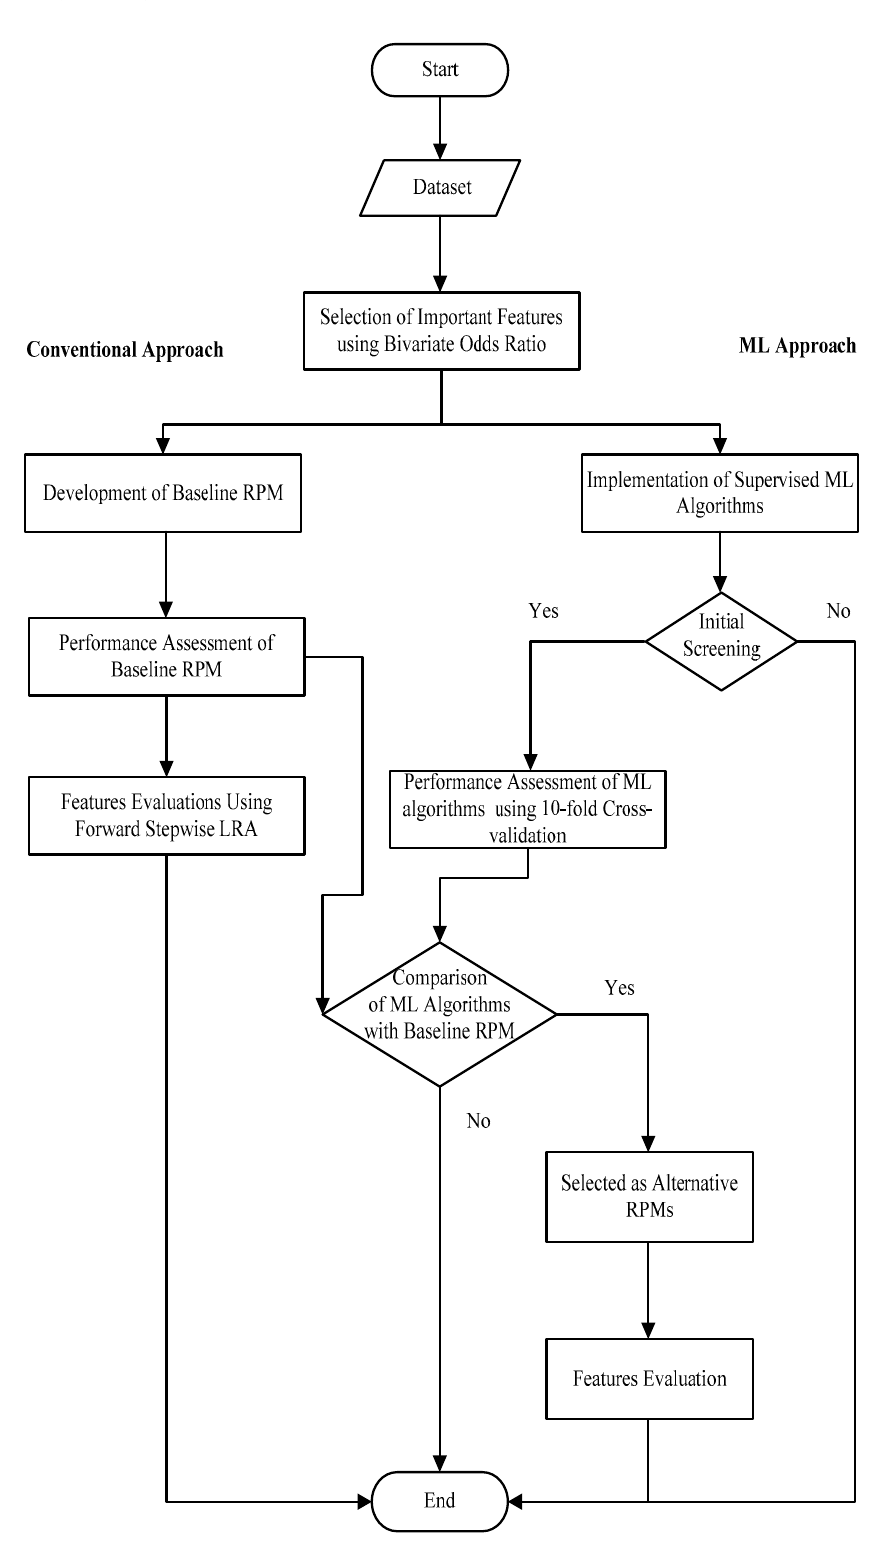
Figure 1. Flowchart for the development of baseline and ML-based RPMs and relative feature importance.